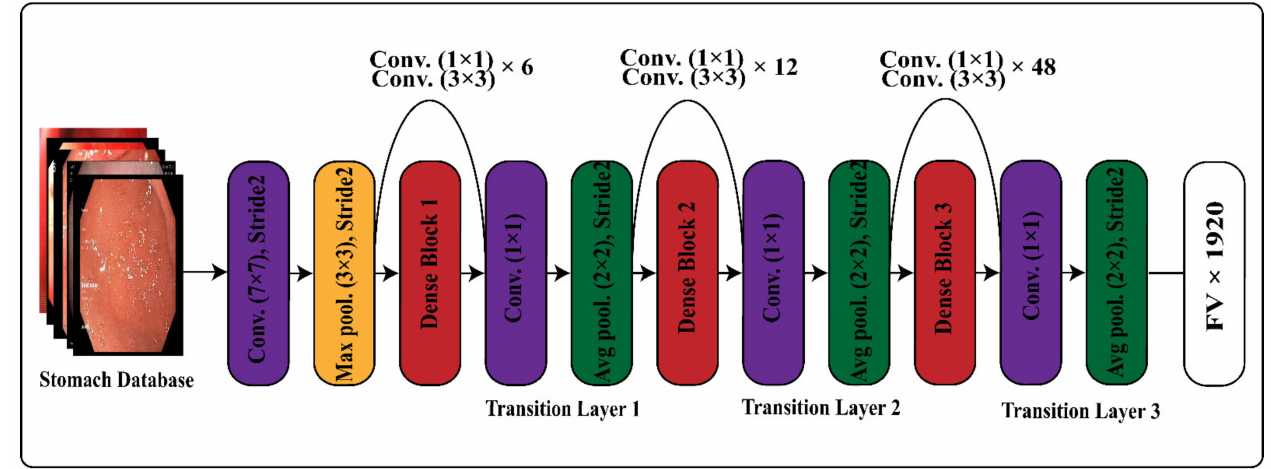
Figure 3. Transfer-learning architecture of DenseNet-201 for feature extraction.